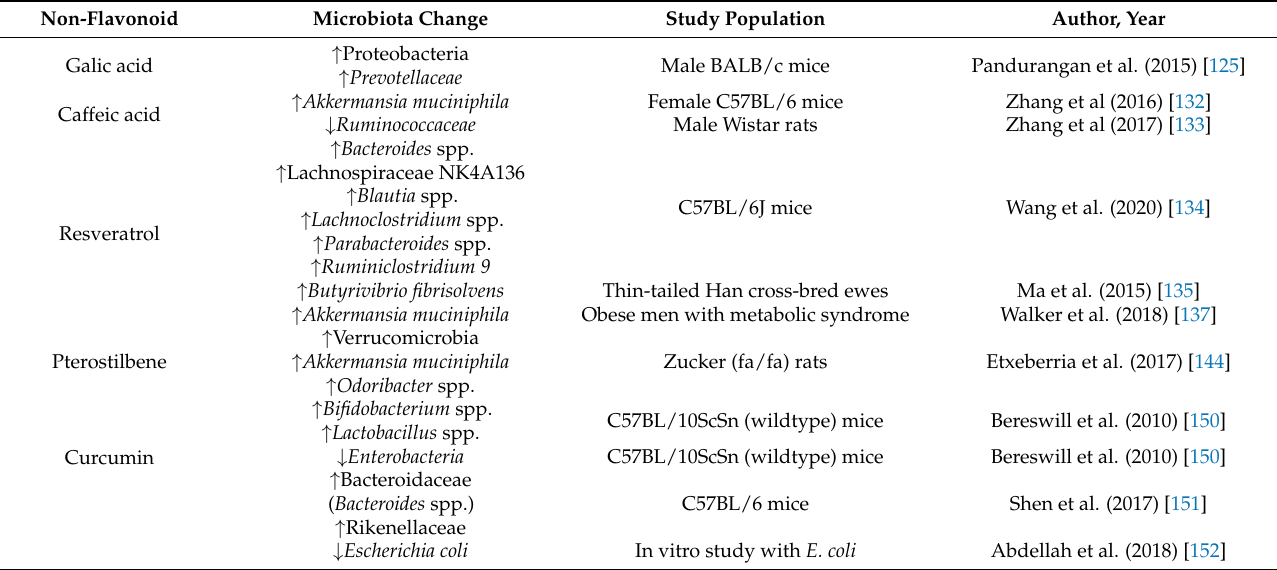
Table 2. Non-flavonoids effects on intestinal